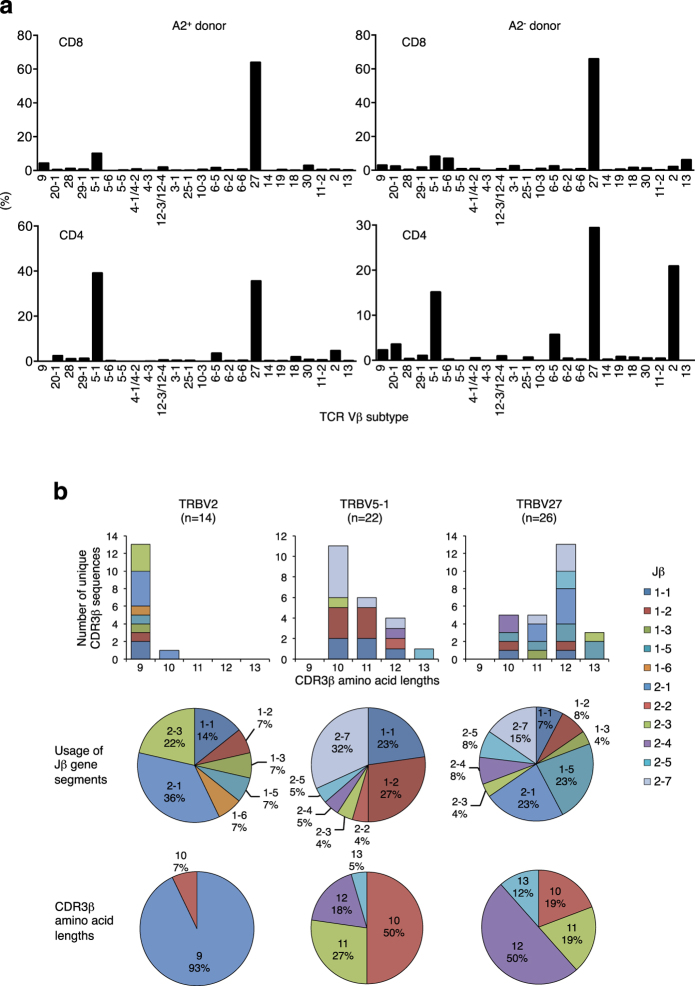
SIG35α predominantly pairs with TRBV2, 5–1, and 27 TCRβ chains with highly heterogeneous and unique CDR3β regions to recognize A2/MART1 in CD4+ T cells.(a) SIG35α/ΔNGFR-transduced peripheral CD8+ (top) and CD4+ (bottom) T cells from HLA–A2+ and A2− donors were stimulated with aAPC pulsed with A2/MART1 peptide twice and stained with anti-NGFR mAb, A2/MART1 multimer, mAbs for TCR Vβ subtypes, and anti-CD8 or CD4 mAb. The percentage of SIG35α+ A2/MART1 multimer+ CD8+ (top) and CD4+ (bottom) T cells expressing each Vβ subtype is shown. The data shown are gated on ΔNGFR+ A2/MART1 multimer+ cells and representative of two independent experiments. The percentage of overall SIG35α-transduced T cells expressing each Vβ subfamily is shown in Supplementary Fig. 2. (b) SIG35α/ΔNGFR-transduced CD4+ T cells from the 2 donors were stimulated with aAPC pulsed with A2/MART1 peptide. ΔNGFR+ A2/MART1 multimer+ CD4+ T cells were collected by fluorescence-activated cell sorting (>99% purity), and their TRBV2, 5–1, and 27 CDR3β regions were amplified by PCR and sequenced after cloning. The number of unique CDR3β sequences (top), the relative usage of Jβ gene segments (middle), and the CDR3β amino acid lengths (bottom) are depicted separately for TRBV2 (left), TRBV5–1 (center) and TRBV27 (right).